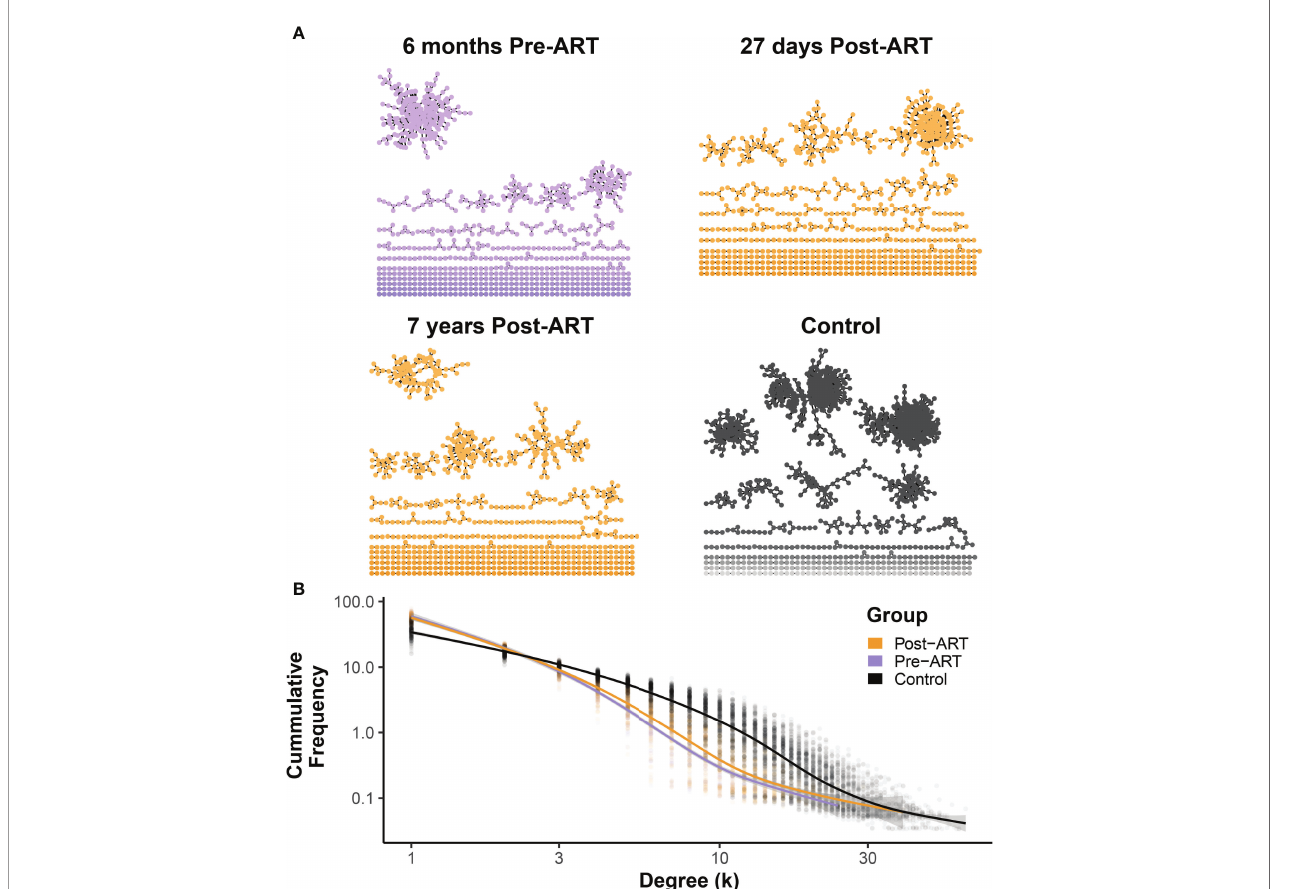
FIGURE 7 | Network structures of pre-ART T-cell b -chain repertoires in PLHIV resemble antigen-experienced repertoires dominated by one-to-many connections, with a small shift following ART initiation toward a many-to-many structure observed in control repertoires. (A) Representative TCR networks of the most frequent 5000 TRB sequences from in the TRB repertoire of PLHIV participant 1001 evaluated at 6 months before ART, 27 days after initiation ART, and 7 years after initiation of ART, and the repertoire of control participant HIP09062. TCR networks were constructed for each of the 188 PLHIV repertoires and the 189 control repertoires by connecting the CDR3 amino acid sequences that differed by an edit distance of 1 with an edge. Each unique CDR3 amino acid sequence forms a node in the network. (B) The degree (number of connections) of each CDR3 amino acid sequence (node) in the network was calculated for the each of 188 PLHIV repertoires and the 189 control repertoires, and the frequency distribution of nodes of different degrees (k) of connectedness for the pre- (purple) and post-ART (orange) PLHIV repertoires and for the 189 control repertoires is plotted. The thick lines represent GAM regression lines tracking the frequency of nodes by degree for each